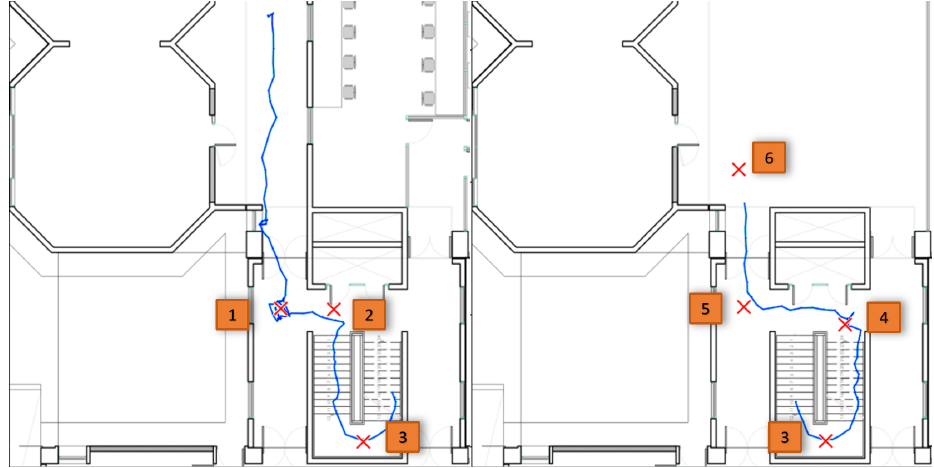
Figure 12. Two-floor navigation following the route from points 1 to 6. Point 3 is located inside the staircase. Table 1. Summary results from having test subjects use the lifejacket’s haptic navigation feature.